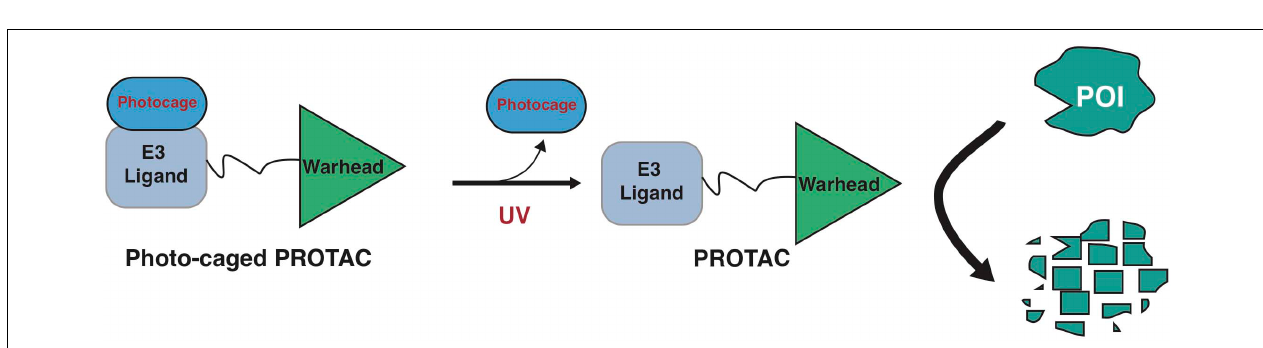
FIGURE 5 | A schematic diagram for action model of photo-switch-PROTAC. The photo-switch PROTACs can be switched on and off by illumination with different wavelengths of light, which leads to the switch between the cis and trans forms of the photo-switch-PROTAC.